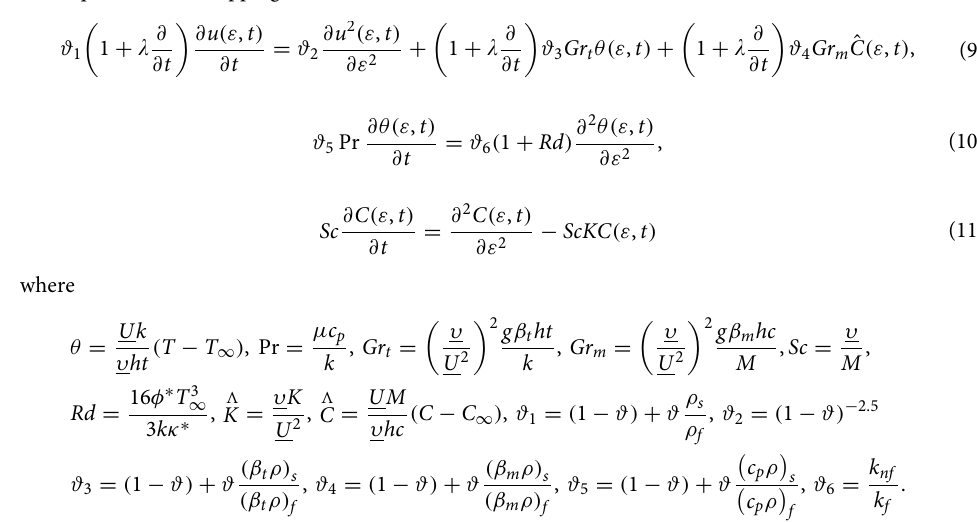
Here, θ denotes the dimensionless temperature, Pr shows Prandtl number, Gr t demonstrates thermal Grashof